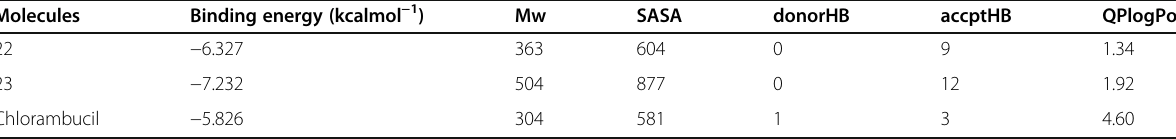
Table 11 Binding affinities and ADME/Tox properties of some of the lead molecules and chlorambucil